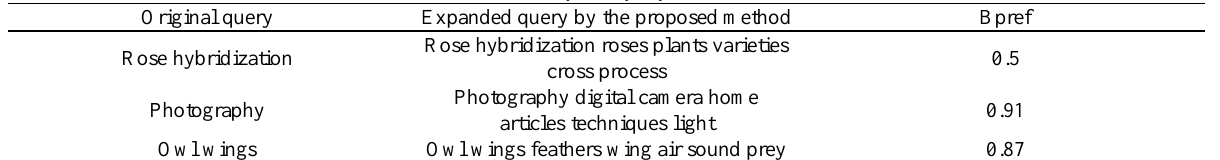
Table 1. Example of proposed method's results